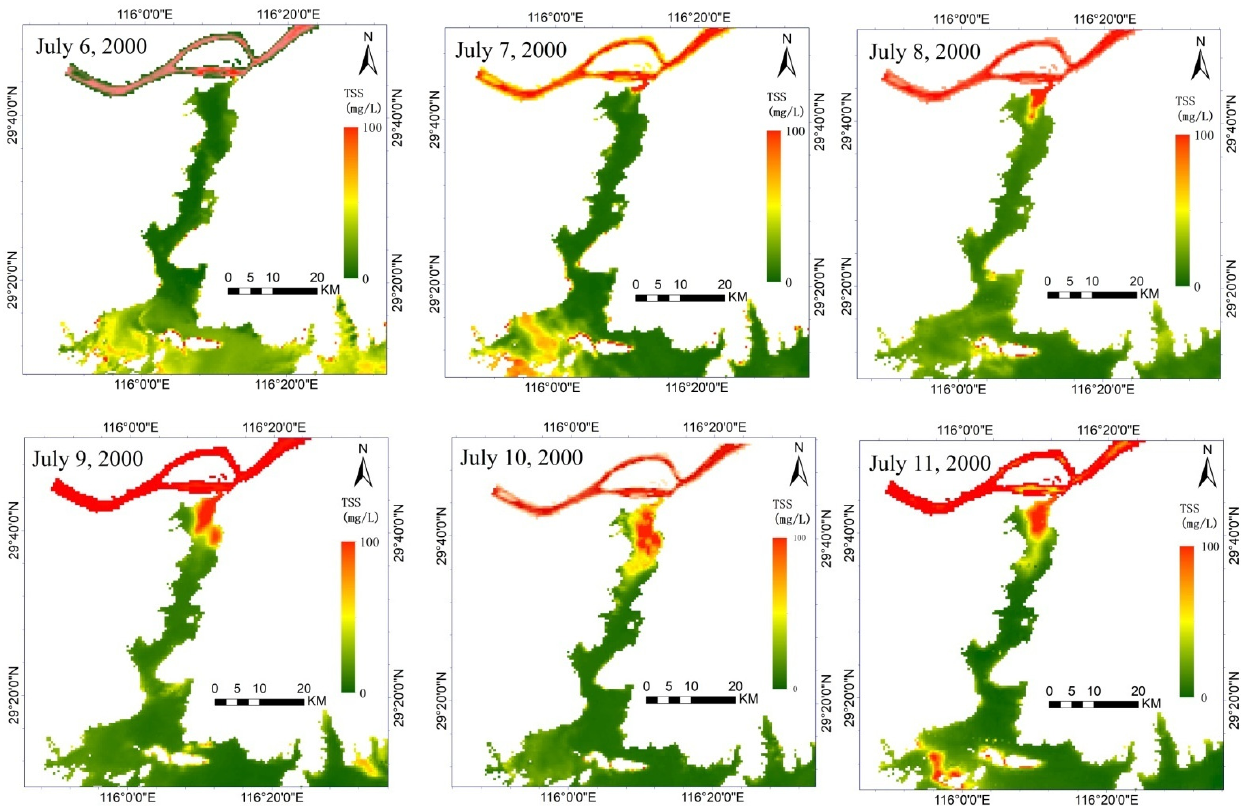
The spatial-temporal distribution of ρ (cid:2904)(cid:2903)(cid:2903) values was estimated by using Formula (5); The MODIS images used were cloud-free images of Poyang Lake taken in July 2000 and in July and August 2007. Figure 6 shows the spatial-temporal distribution of ρ (cid:2904)(cid:2903)(cid:2903) in Po- yang Lake during the period of a BRL in July 2000. To contrast the TSS variation before and after the BRL, the TSS distributions from 6 to 11 July 2000 are shown. The northern lake was rather clear with TSS of <5 mg/L. However, a red portion ( ρ (cid:2904)(cid:2903)(cid:2903) > 50 mg/L) at the exit of the lake appeared and gradually became larger and larger.